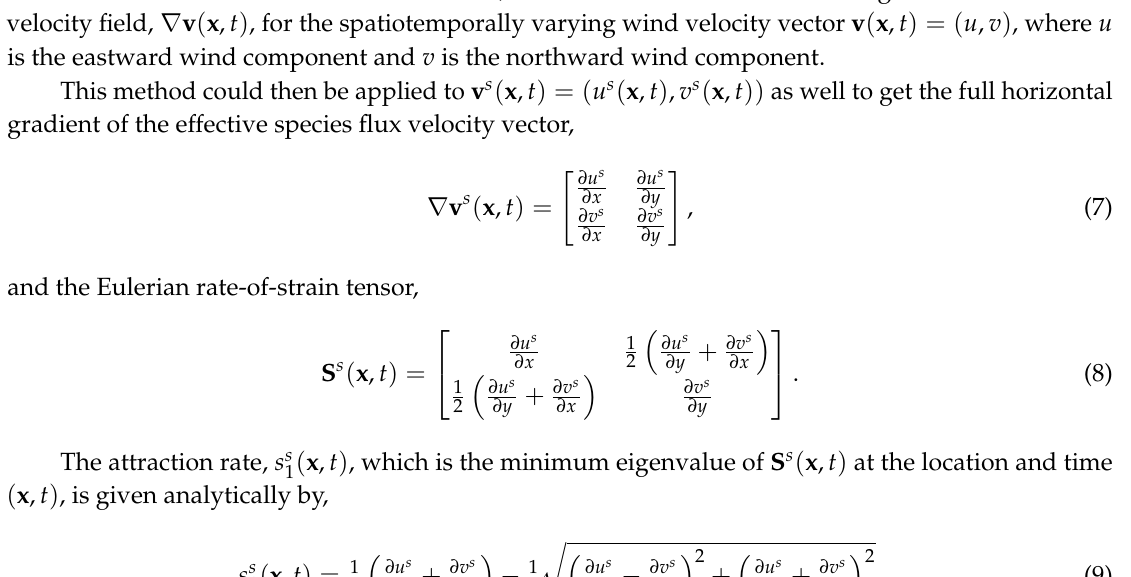
Figure 1. Schematic of the effect of a ridgeline of the negative of the attraction rate, parcel of the concentration of species s . F s